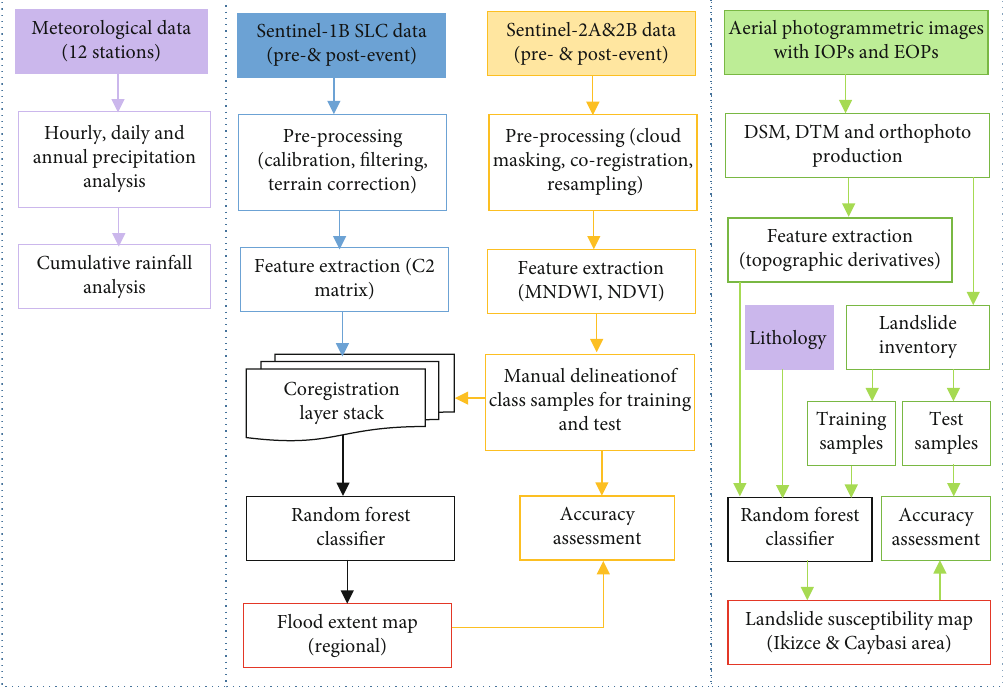
Figure 4: Overall methodological work fl ow of the